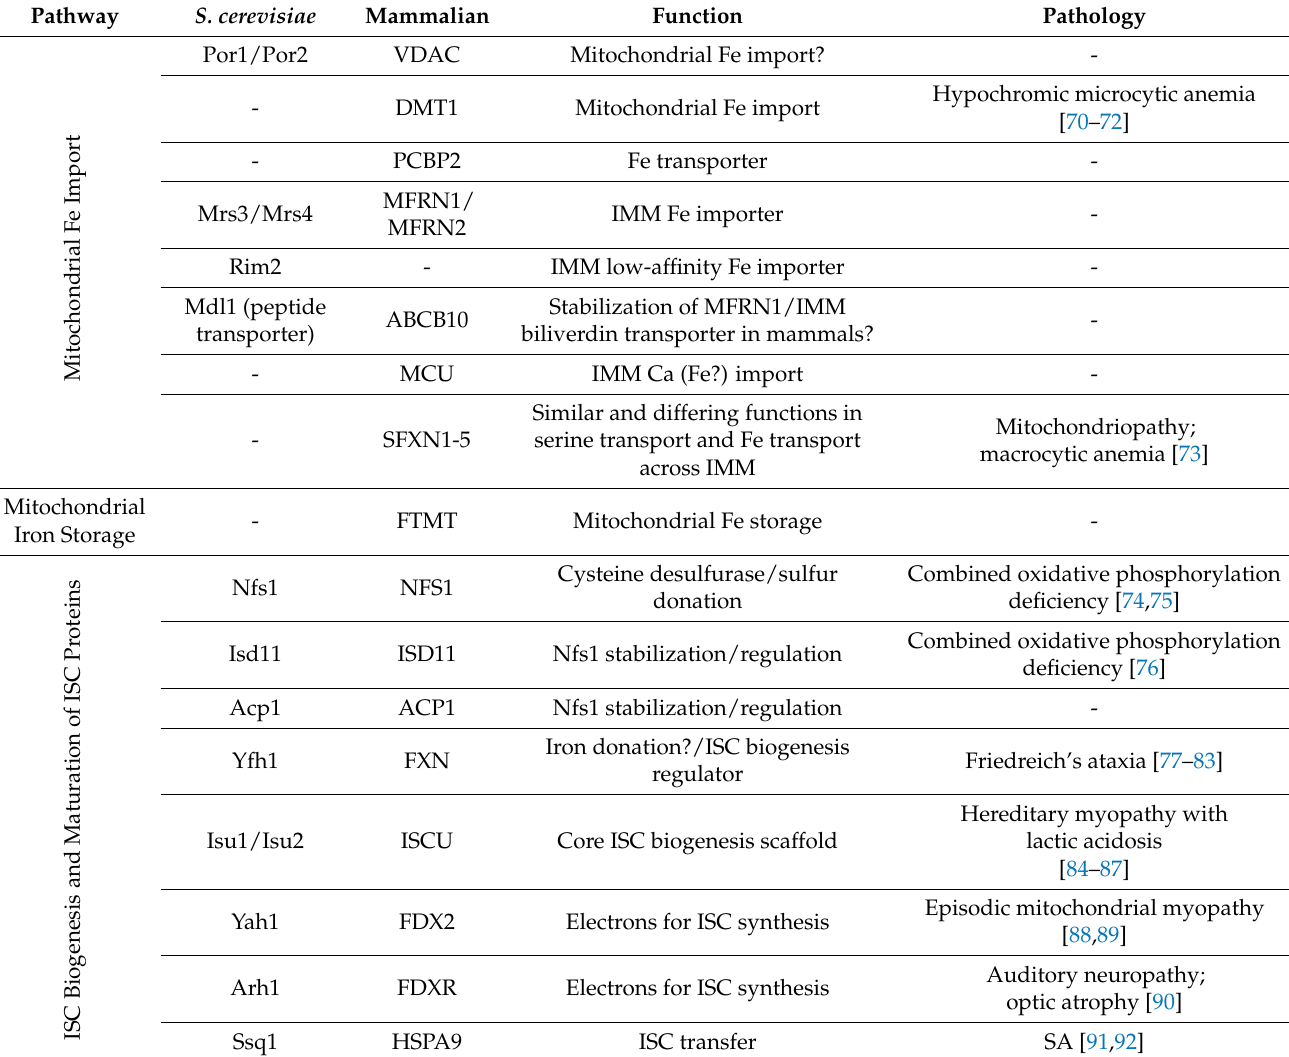
Table 1. Conservation of proteins involved in maintaining mitochondrial iron homeostasis. (SA = sideroblastic anemia; MMDS = multiple mitochondrial dysfunctions syndrome).